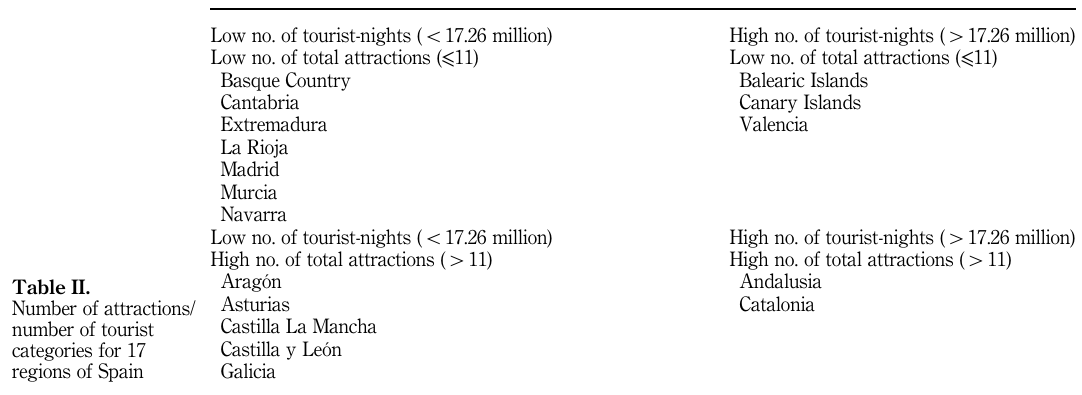
Andalusia Catalonia